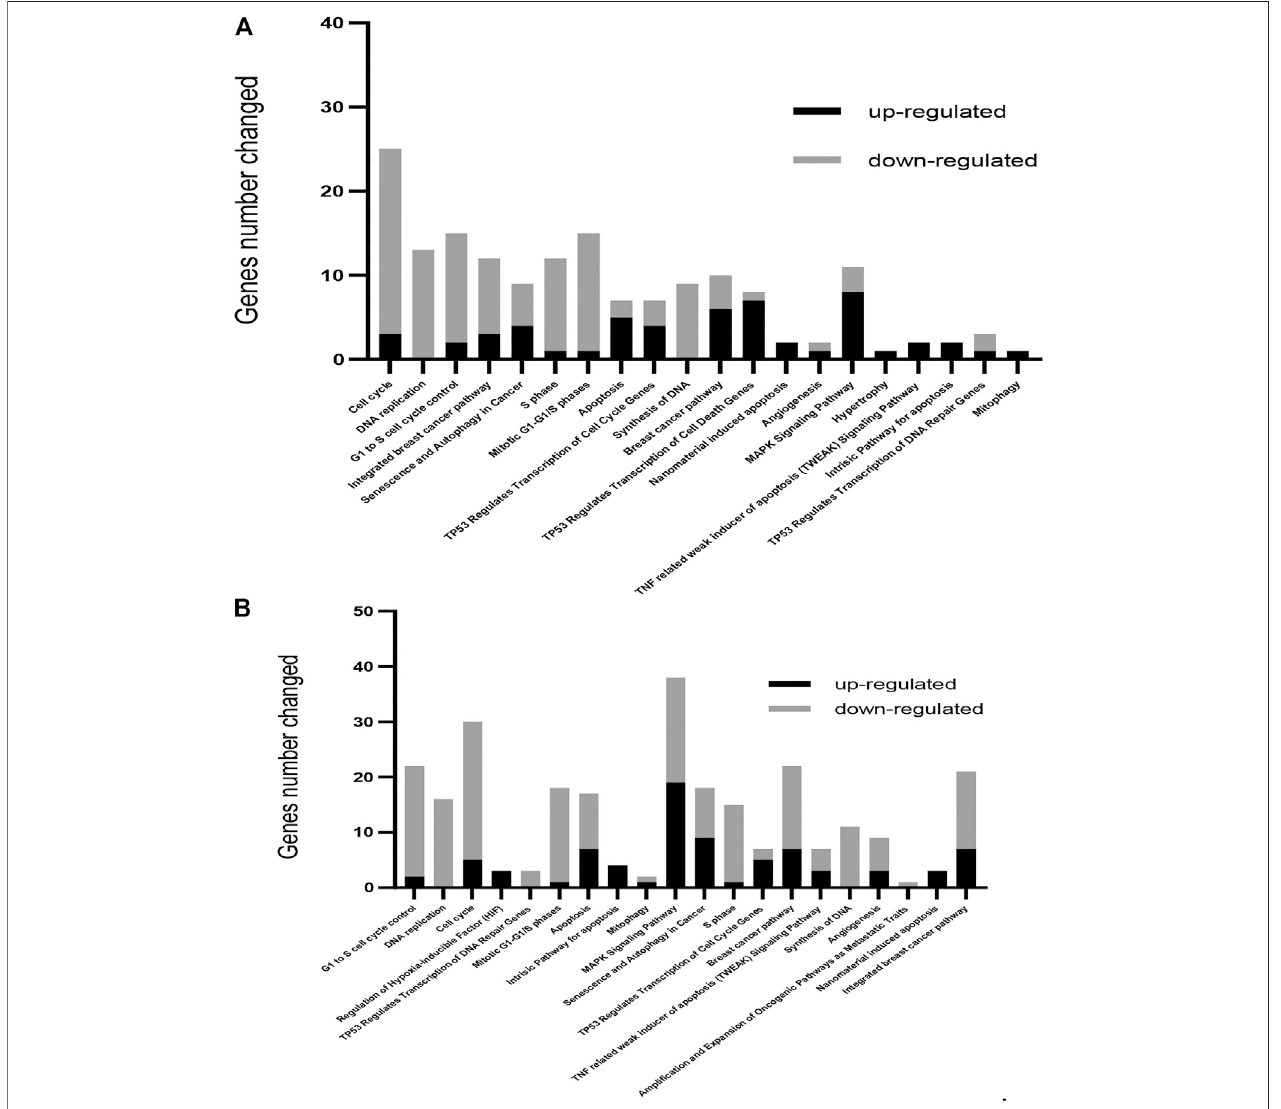
FIGURE3 | Gene ontology-basedbiologicalprocess pathways altered by OXYin MCF-7 breast cancer cells. Differentially expressed genesinMCF-7 cellstreated with50 µM (A) or100 µM (B) ofOXYfor24 h. Todeterminethe biologicalprocess and pathways involved,thelist ofsigni fi cantlyupregulatedand downregulatedgenes was analyzed using Fisher ’ s Exact Test, and then analyzed using